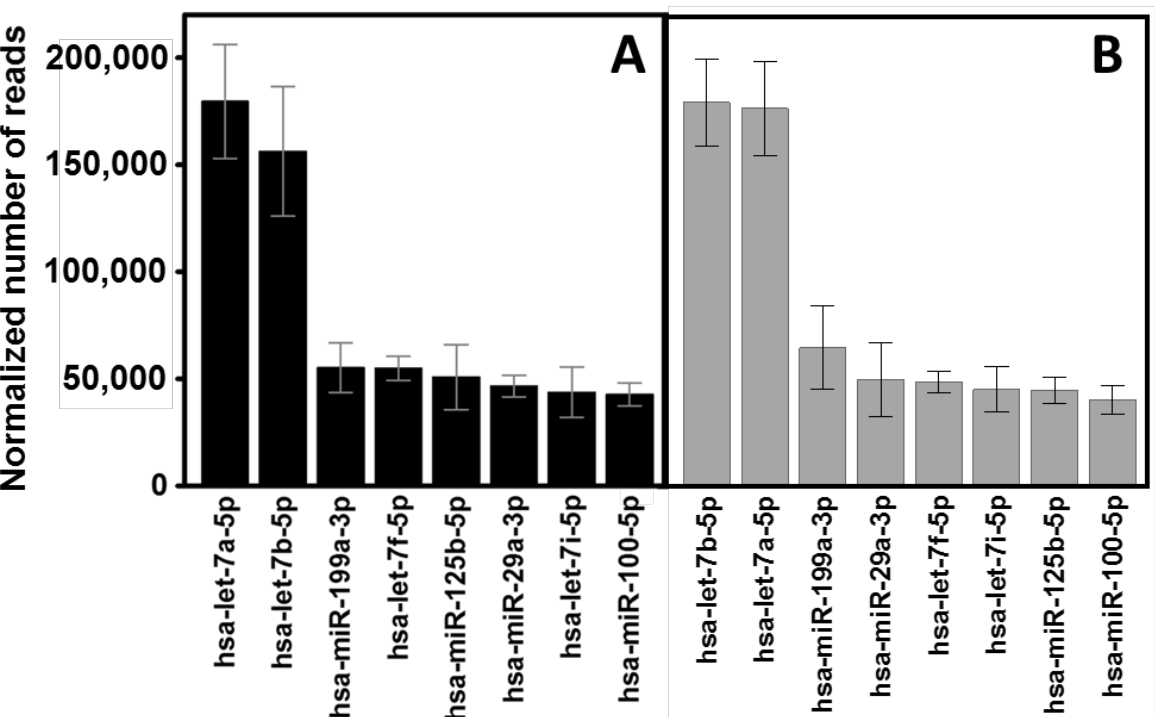
Figure 5. Expression of the 8 most abundant miRNAs in corneal stromal cell exosomes. ( A ) healthy cells. ( B ) KC cells. The spreads represent standard deviations.